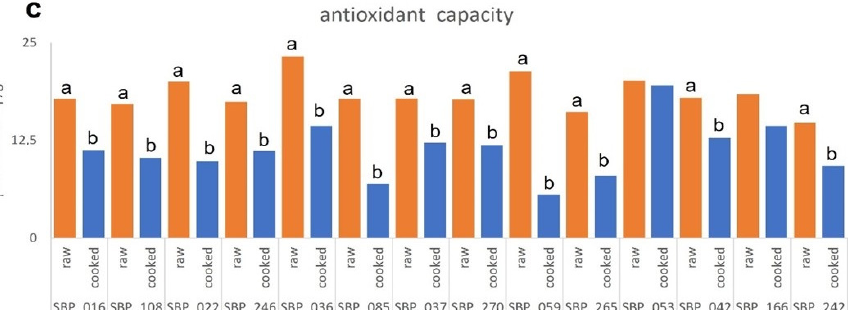
Figure 4. Mean content for the quercetin-3-O-rutinoside ( a ), kaempferol-3-O-rutinoside ( b ), and antioxidant activity (TEAC) ( c ) in the raw and cooked samples of each selected line investigated. Different letters mean significant differences ( p ≤ 0.05). No letters mean no significant